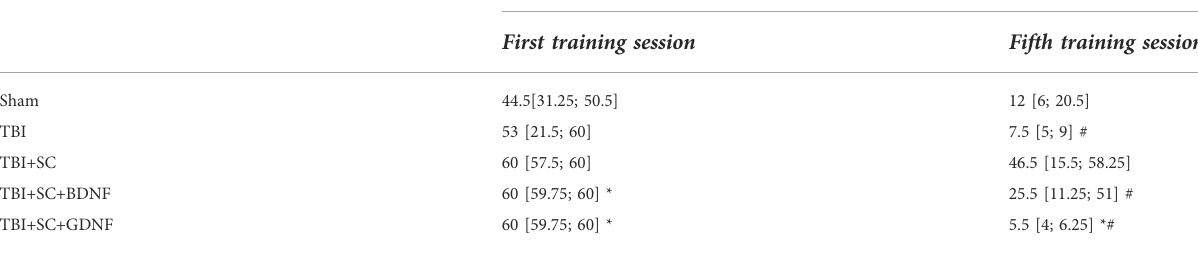
TABLE 4 Analysis of learning ability of mice in the Morris water maze after traumatic brain injury followed by scaffolds implantation. Experimental